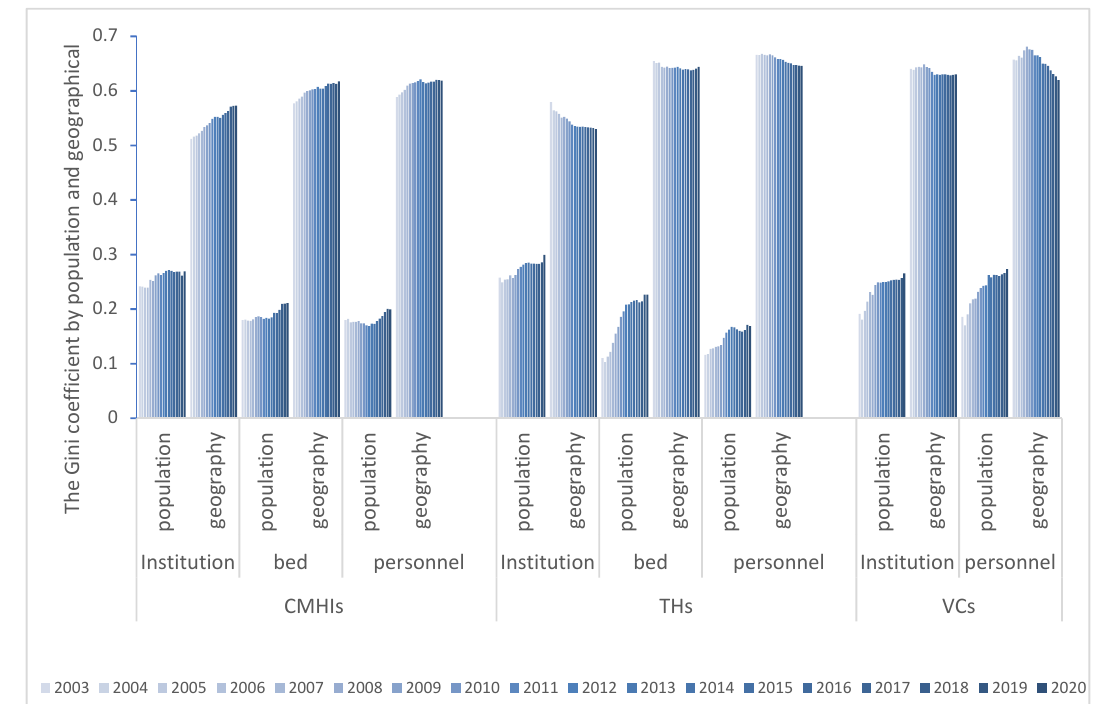
Figure 2. The Gini coefficient for healthcare resources by population and geographic areas in China from 2003 to 2020 (CMHIs: county and county-level city medical and health institutions; THs: township hospitals; VCs: village clinics).